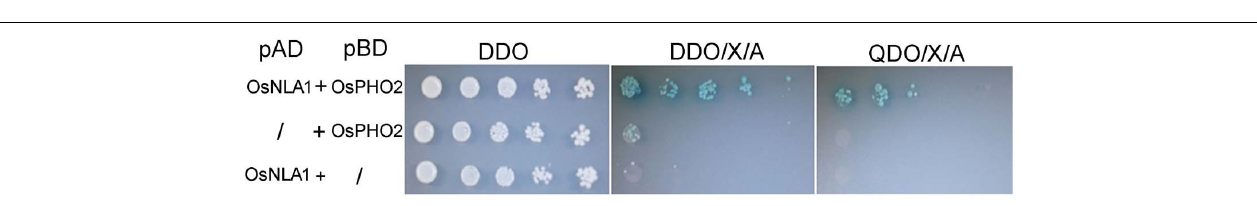
OsSPX5 is mainly expressed in root tissues (Wang et al.,